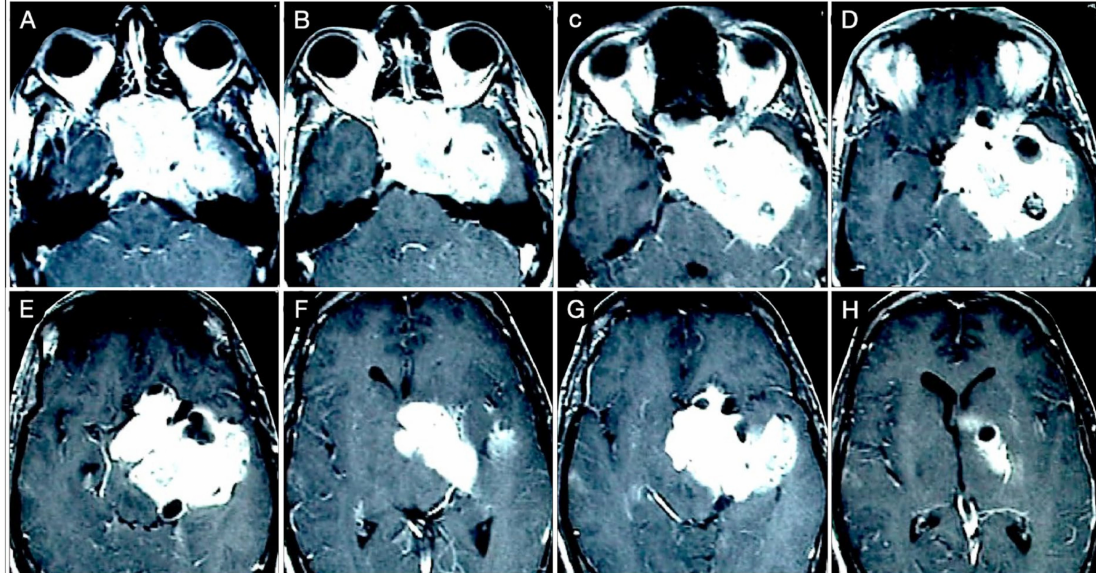
Figure 14. Preoperative axial ( A – H ) T1-weighted contrast-enhanced MRI. Scale bar: 5 cm.